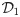
The results of maximum likelihood (ML) parameter fitting to dataset D1.After fitting, we see (A) the removal of the spike-related kernel through the difference between the recorded trace usom* and the subthreshold membrane potential u+u
r; (B) the match of the stationary distribution of the subthreshold potential u and a Gaussian. We also observe that (C) the autocorrelation function of the data, Eq (14), is well reproduced by k(t) in Eq (15); (D) the spike-related kernel α(t) starts at −δ = −18 ms relative to the peak of the action potential. The difference between the spike-triggered average (STA) and the spike-related kernel is attributed to the GP; and (E) that the adaptation kernel η(t) shows distinct modulation of firing rate which produces firing statistics significantly different from a Poisson process. This is also reflected in the inter-spike interval density ρ(τ) (F) of the data, which shows good qualitative agreement with a simulated AGAPE with adaptive kernel as in (E) (thick red line), but not by a non-adaptive (i.e. Poisson) process (thin red line). After fitting, a two second sample of synthetic data (H) looks similar as the in vivo data (G). In (G, H) vertical lines are drawn at the spiking times. All red shaded regions denote ± 2 standard deviations, estimated from the observed Fisher information.